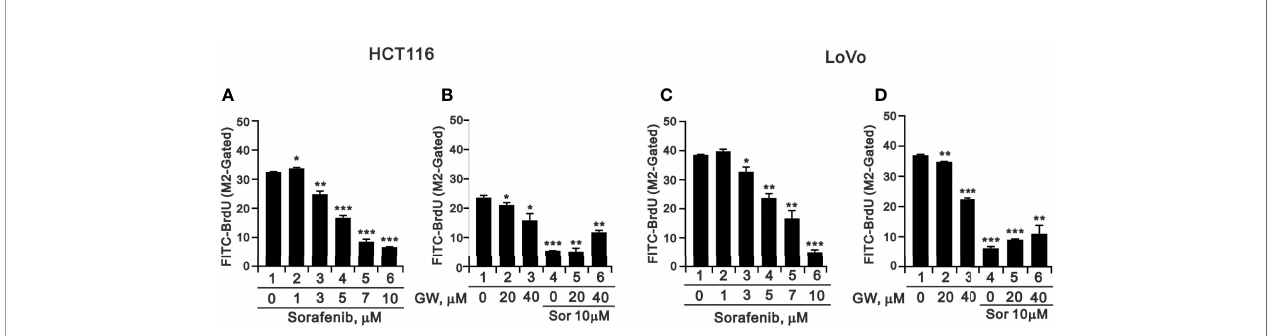
FIGURE 5 | The effects of GW5074 and sorafenib on cellular proliferation of HCT116 and LoVo cells. HCT116 (A) and LoVo (C) cells were treated with 0, 1, 3, 5, 7, and 10 µM sorafenib for 24 h. HCT116 (B) and LoVo (D) cells were treated for 24 h with 0, 20, and 40 µM GW5074 in the absence or presence of 10 µM sorafenib. They were subjected to BrdU proliferation analysis. The results are representative of three independent experiments. * p < 0.05, ** p < 0.01, and *** p <